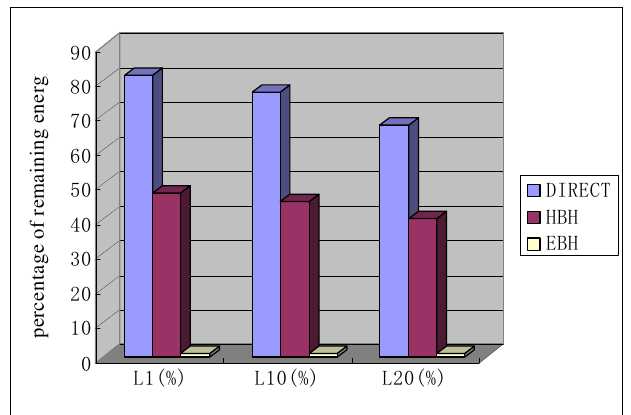
Figure 10. The average remaining energy